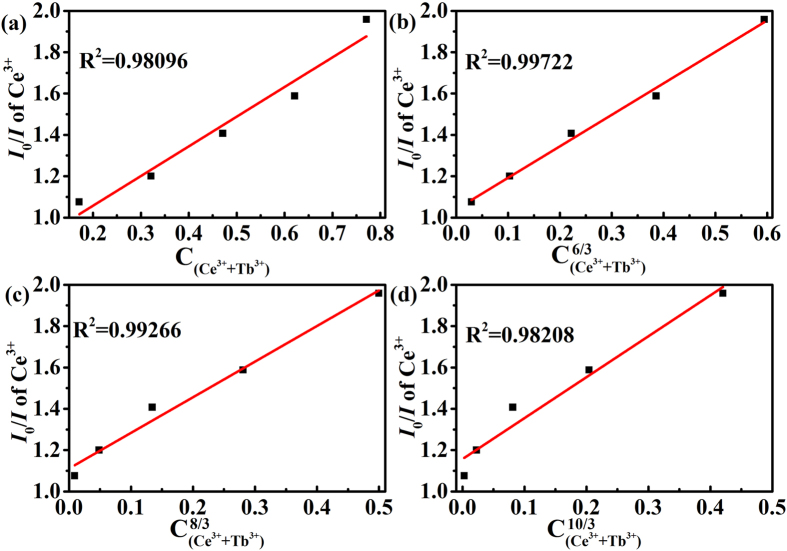
The dependence of I0/I of the Ce3+ ions on (a)  (b)  (c)  (d) .